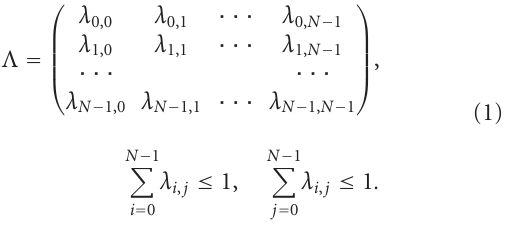
algorithm to decompose an admissible tra ffi c rate